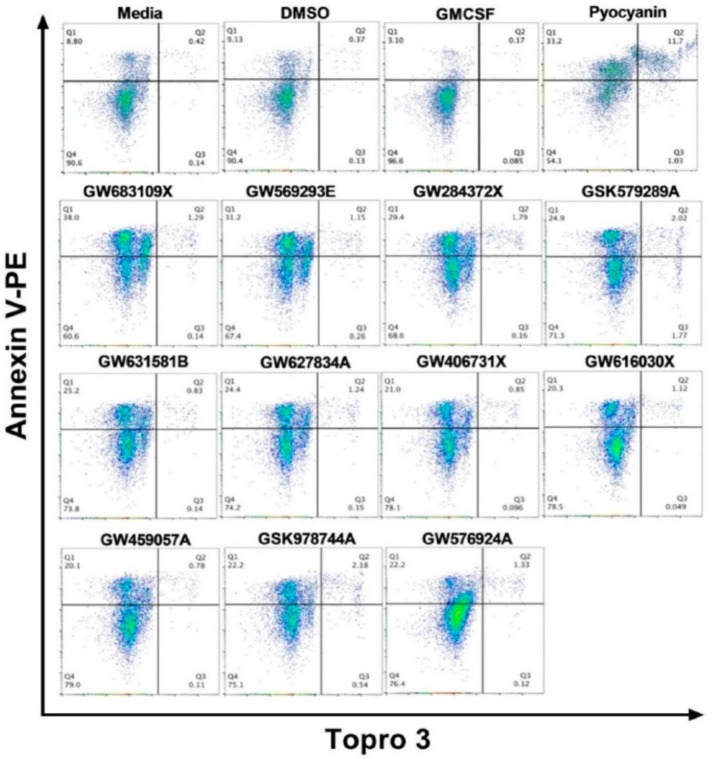
Flow cytometry dot plots for screen validation.Human neutrophils were incubated for 6 hr with PKIS compounds identified as being pro-apoptotic from the first round of screening (Figure 1B). Neutrophils were also incubated with controls as follows: media, DMSO (vehicle), GM-CSF (anti-apoptotic) or pyocyanin (pro-apoptotic). Figure shows annexin-V (y-axis) and ToPro-3 (x-axis) flow dot plots for all compounds that accelerated apoptosis <2 fold over DMSO control. Dot plots are representative of 3 independent experiments.